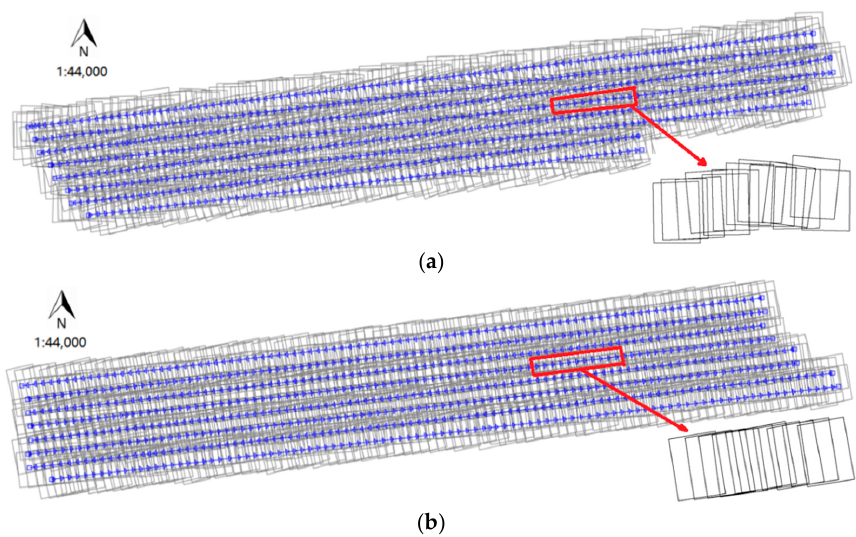
Figure 11. Footprint views of dataset with the rotation angles. ( a ) Zhang Jiakou block1; ( b ) Zhang Jiakou block2.